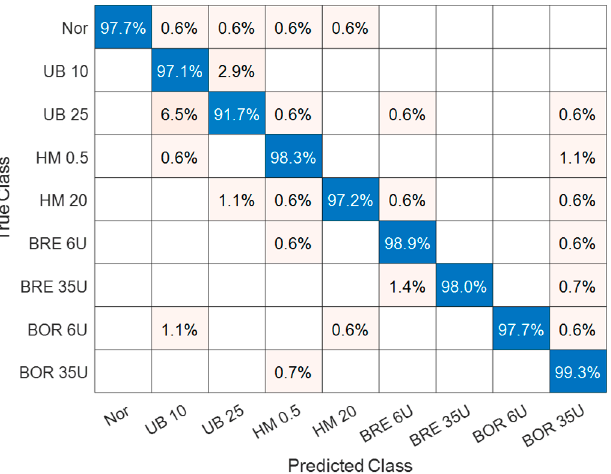
Figure 20. Test confusion matrix of SVM on features automatically extracted by the pretrained deep learning model from the data of the MFS kit.